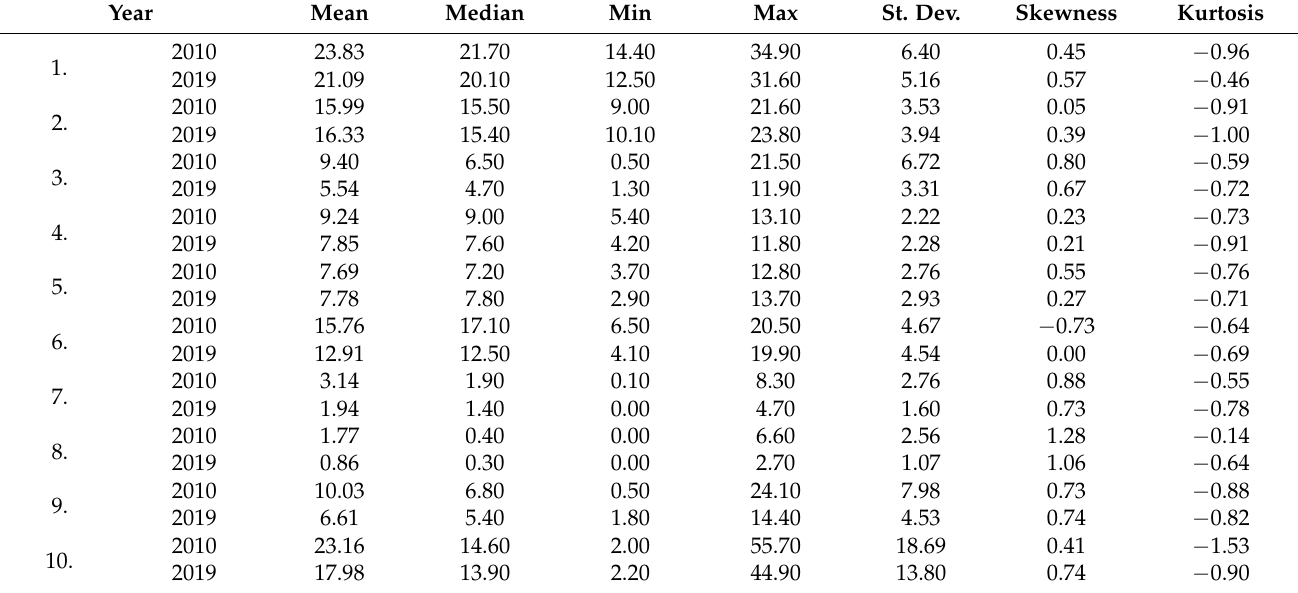
Table 2. Values of basic descriptive parameters of no poverty indicators for EU countries in 2010 and 2019 for winsorized